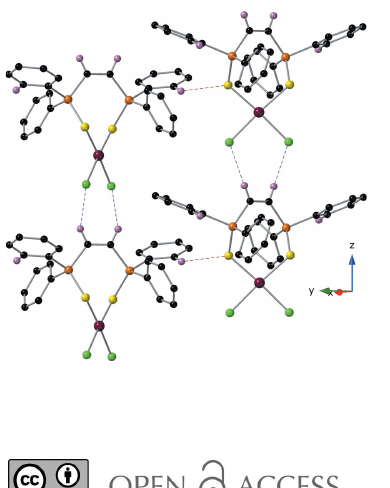
Figure 1 Reaction conditions used to prepare the title